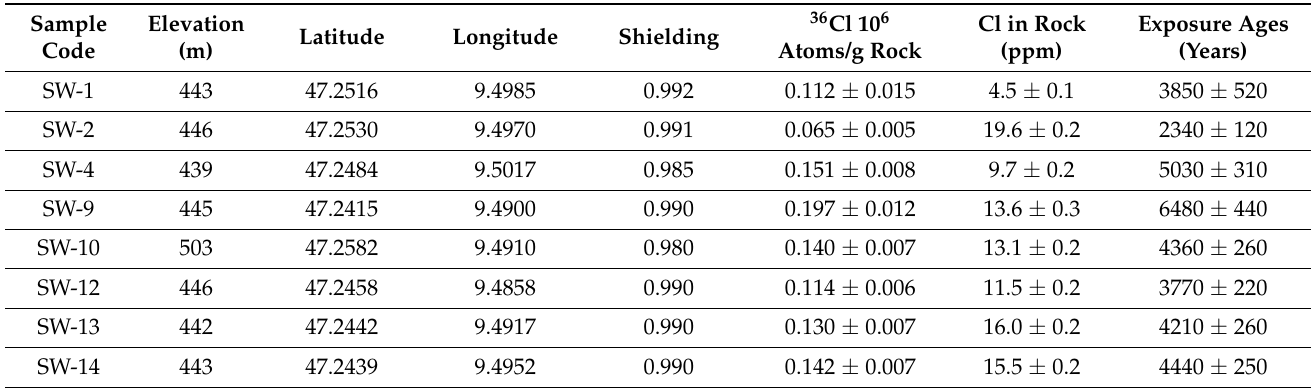
Table 1. AMS-measured 36 Cl concentrations and exposure ages with error margins for the Sennwald landslide.